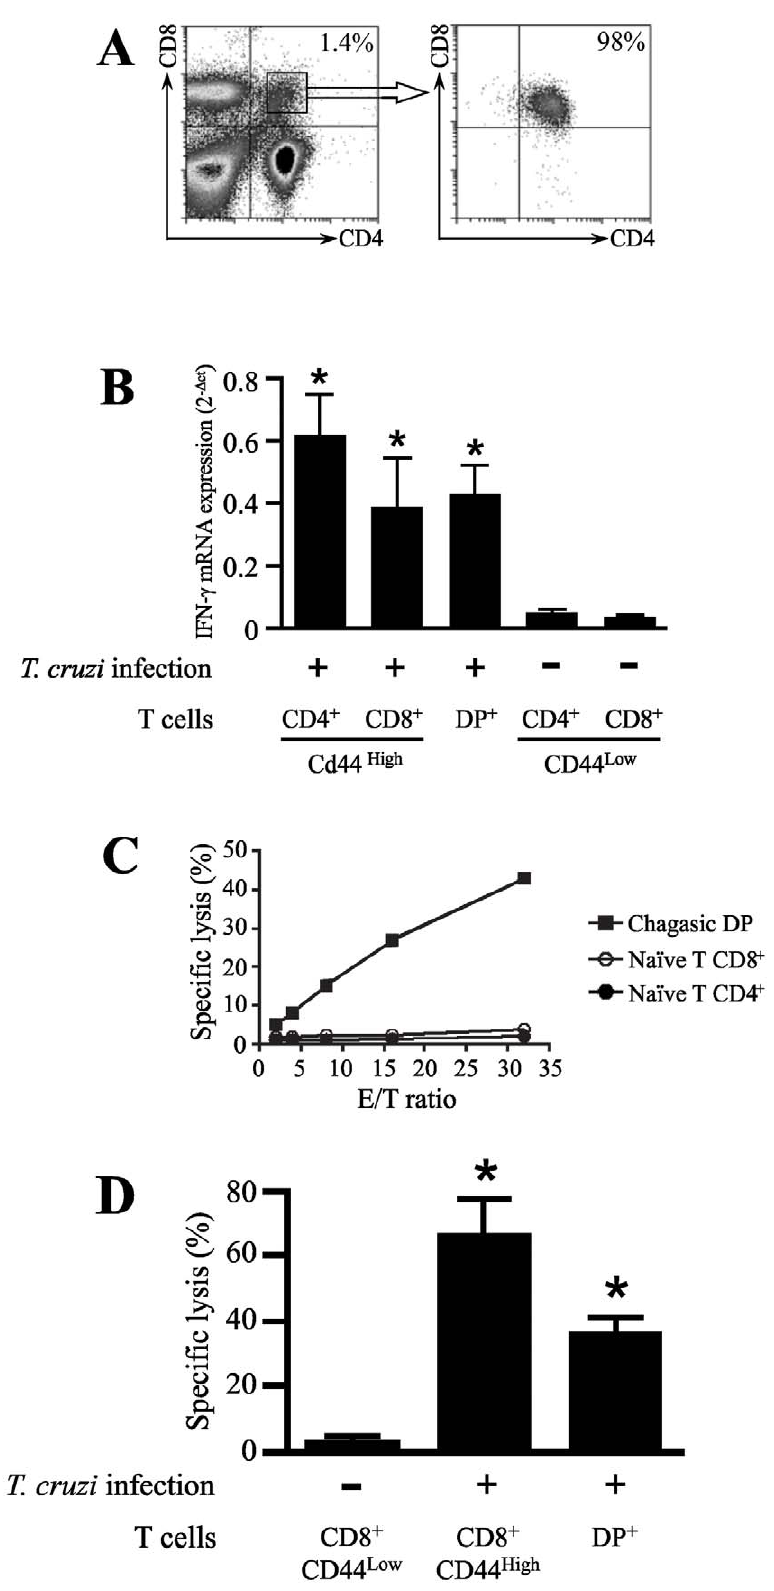
Figure 6. mRNA levels for IFN- c and cytotoxic activity of peripheral DP T cells during T.cruzi infection. (a) CD4 + CD8 + T cells from acutely-infected mice were purified from subcutaneous lymph nodes 15d after infection, by cell sorting using flow cytometry. (b) To assess IFN- c transcriptional levels, total mRNA from highly purified fresh DP, CD4 + and CD8 + T cells (as indicated) were processed for RT-PCR. The results represent